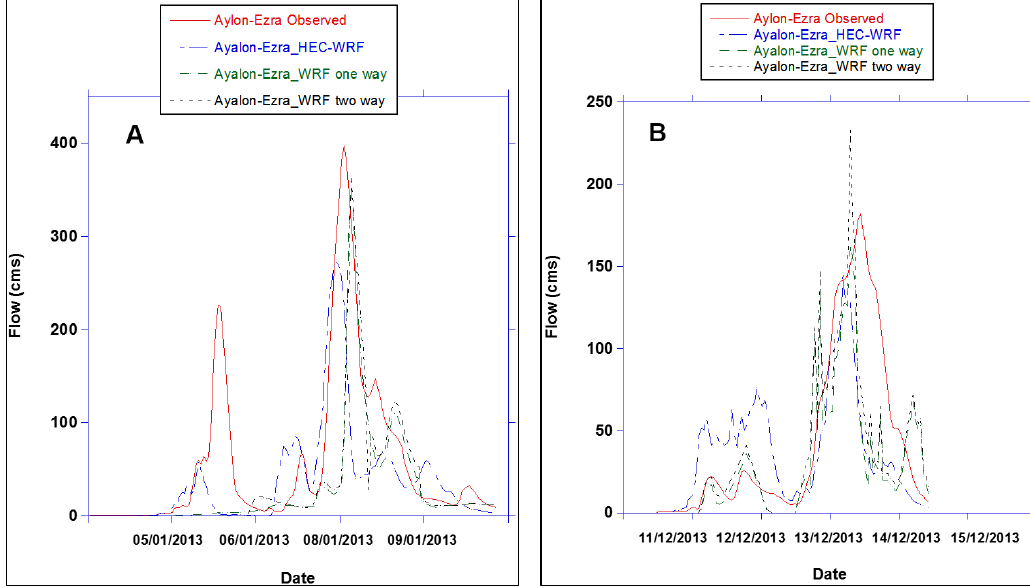
Figure 9. Observed hydrograph at Ayalon–Ezra hydrometric station ( red ) and simulate hydrographs when the HEC-HMS ( black ) and WRF-Hydro one way ( blue ) models are driven by WRF simulated precipitation and the green hydrograph represent the WRF two way simulation for the January ( A ) and December ( B ) storms.